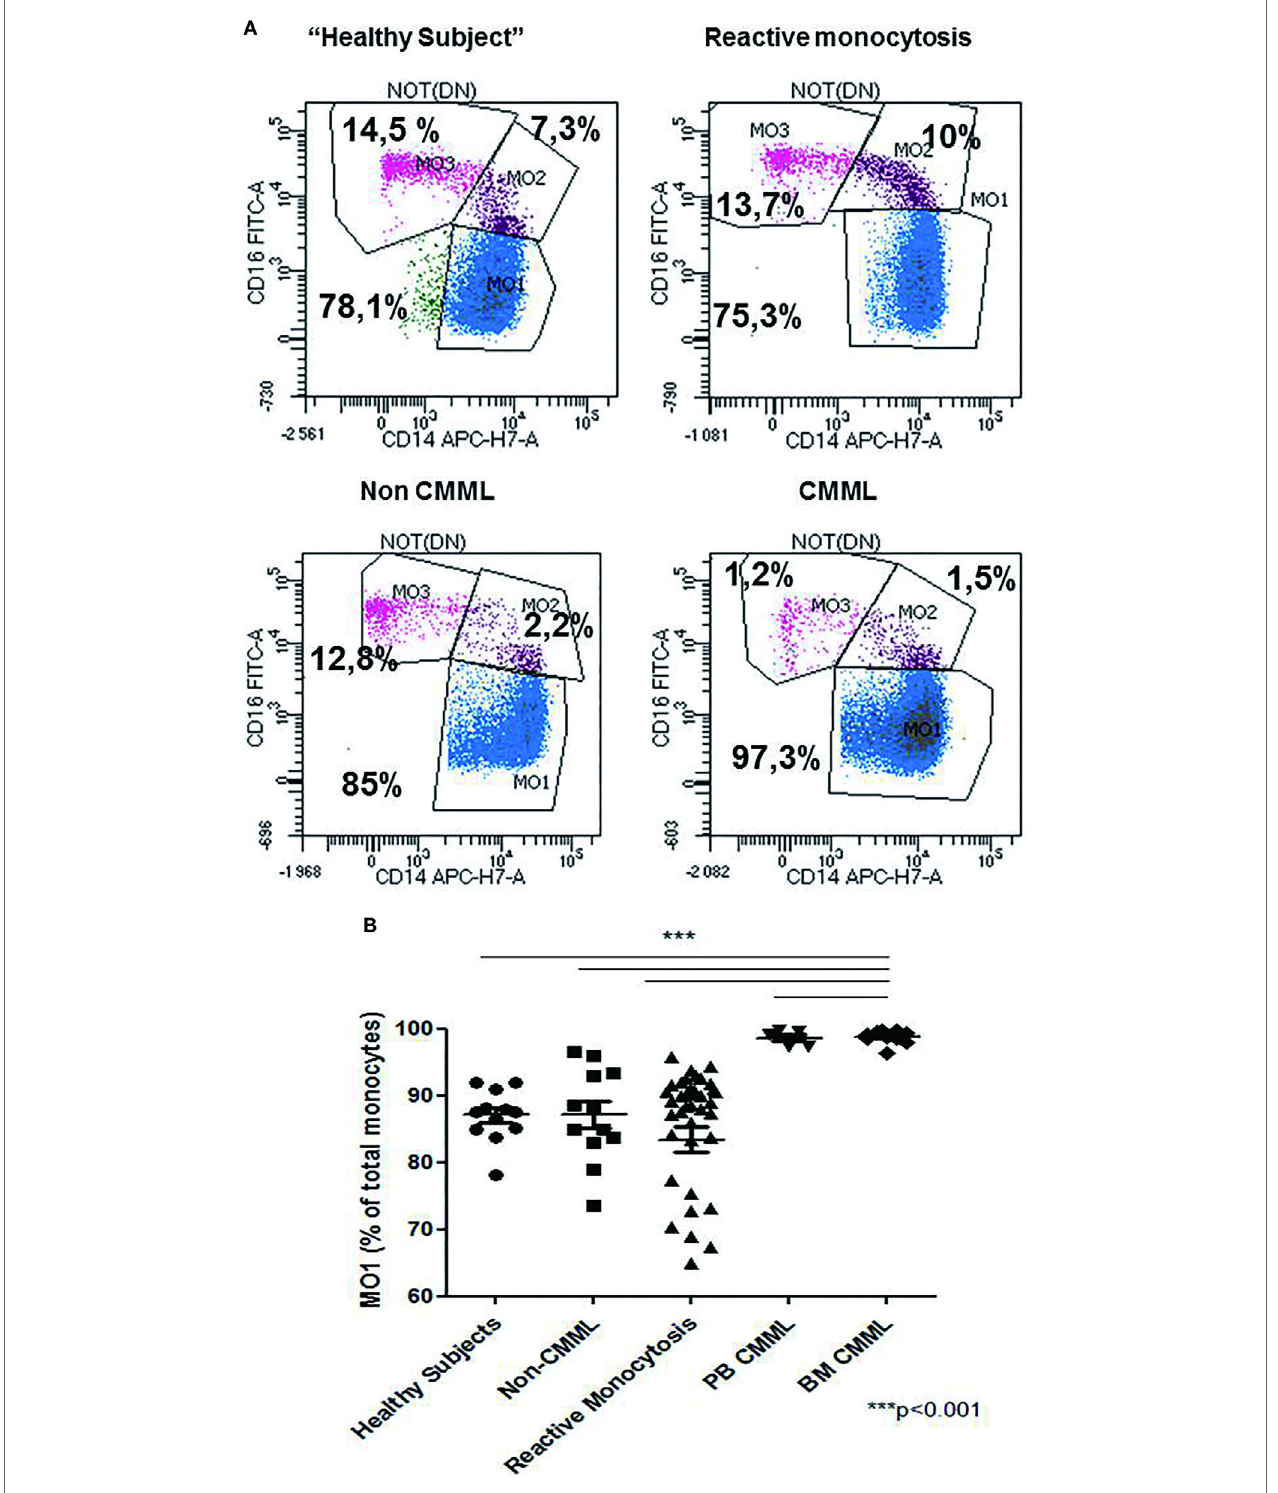
FigUre 2 | Repartition of monocytes subsets in different groups of cases. Monocyte subset repartition in distinct groups [ n = 12 “healthy subjects,” n = 15 chronic myelomonocytic leukemia (CMML), n = 36 reactive monocytosis, n = 12 hematological diseases or non-chronic myeloid leukemia (CMML) ( n = 1), MDS ( n = 2), AML ( n = 4), myeloma ( n = 1), and myeloproliferative syndromes ( n = 4)]. For each group, the monocytes subsets expressed as percentage of total monocytes are displayed (a) . Relative frequencies of the MO1 subset in different groups ( n = 12 “healthy subjects,” n = 12 non-CMML, n = 36 reactive monocytosis > 1 × 10 9 , n = 5 peripheral blood CMML, and n = 10 bone marrow CMML) (B) . Fisher test was performed in order to compare each group of cases with healthy subjects. *** p < 0.001.